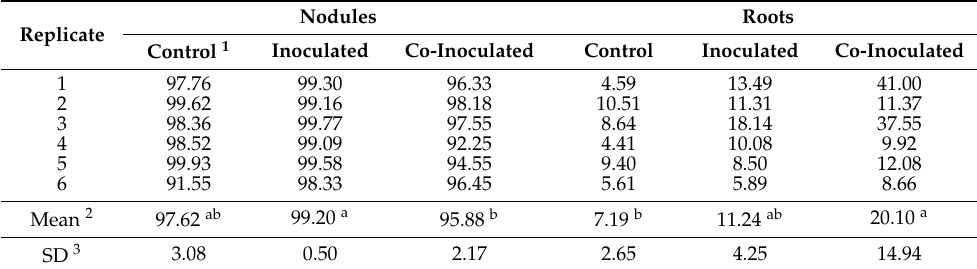
Table 1. Relative abundance (%) of Bradyrhizobium in the microbiomes of nodules and roots of soybean (i) non-inoculated (control); (ii) inoculated with Bradyrhizobium spp.; and (iii) co-inoculated with Bradyrhizobium spp. and Azospirillum brasilense